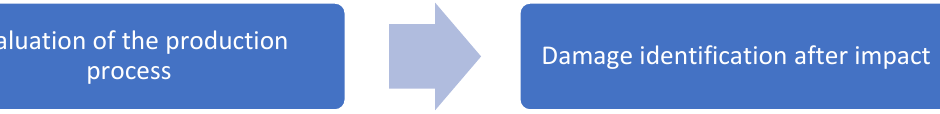
Figure 9. Phased array and IR-thermography test plan on RTM6 impact specimens.